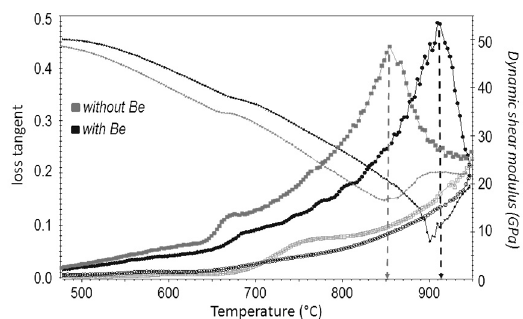
Figure 1. Mechanical loss and dynamic shear modulus measured during the first heating after cold rolling and the subsequent cooling, for CW samples without beryllium (grey) and with beryllium